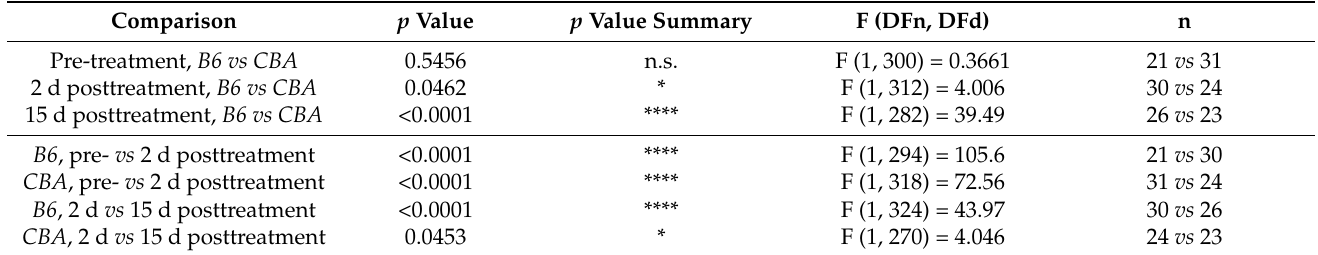
Table 1. Ordinary two-way ANOVA statistics on 400 G/200 F-induced ABR threshold shifts. n.s. = not significant. * p < 0.05, **** p < 0.0001.